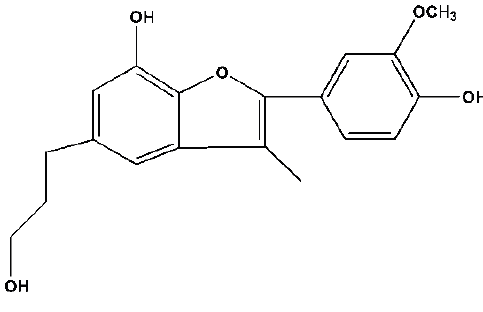
Figure 3. Key HMBC ( → ) and COSY ( − ) correlations of cecarbon.